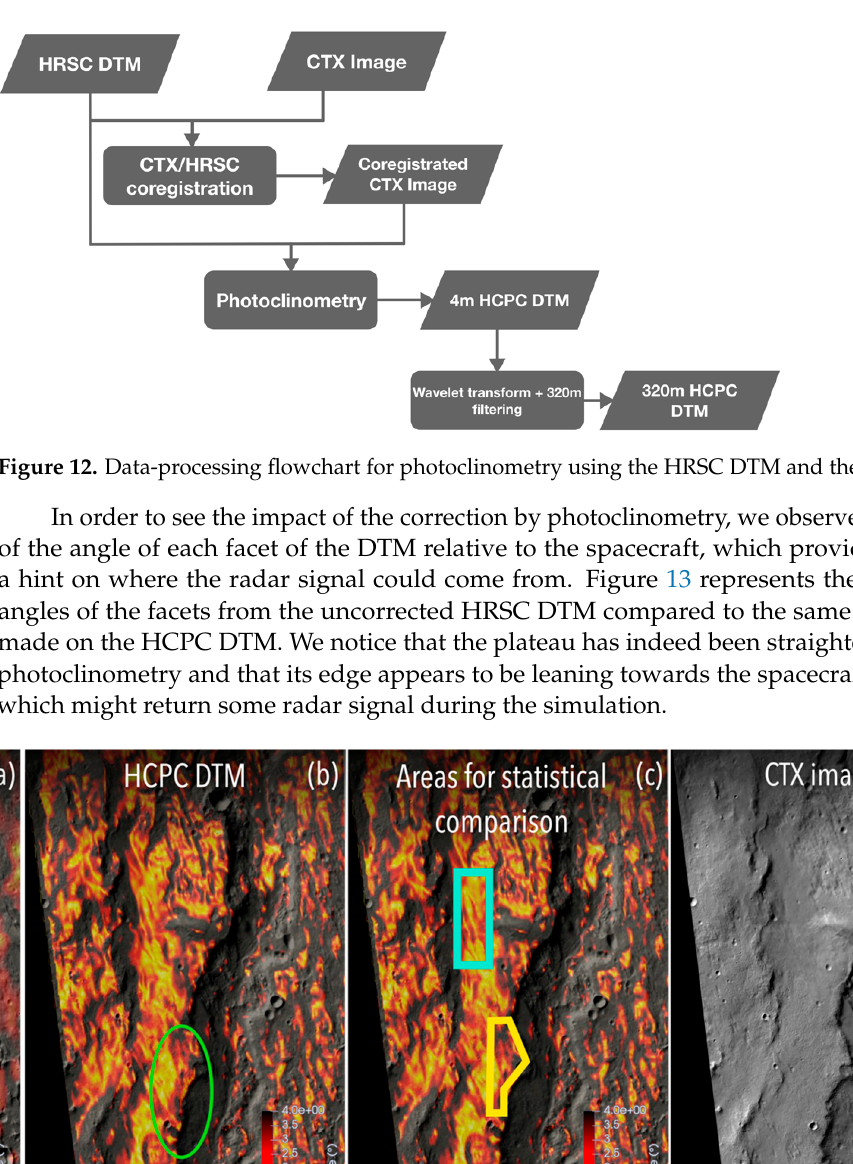
Figure 11. Comparison between vertical exaggeration of topographies (exaggeration factor of 20) for the HRSC DTM with a CTX image mapped on it ( a ) and the HCPC DTM ( b ). The edge of the circled plateau was straightened by photoclinometry.